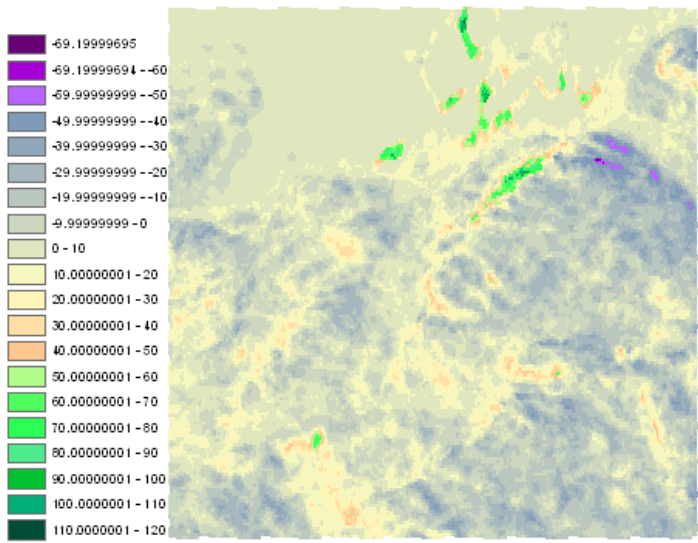
Figure 1a. ASTER GDEM v2 and OSGB Height Differences, for Plockton, created from Figs. 2a and 2b (below) . Green pixels are those whose positive difference exceeds three times the RMS Difference and purple pixels are those whose negative difference exceeds three times the RMS Difference, coinciding with steep forested areas and intertidal islands, in this case, as can be seen in Figure 1b.